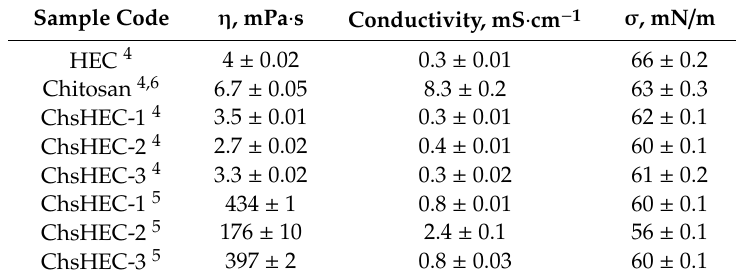
Table 3. Characteristics of the aqueous solutions of initial polymers and ChsHEC samples.